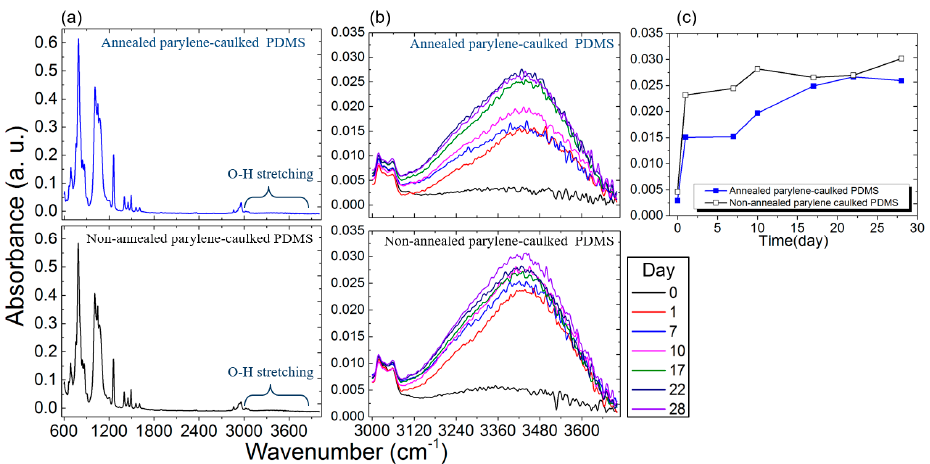
Figure 3. ( a ) Initial FTIR spectrum as soon as the electrodes were immersed in PBS solution; ( b ) FTIR spectrum from 3000 cm − 1 to 3700 cm − 1 to show the water amount absorbed in substrates of annealed pc-PDMS and non-annealed pc-PDMS for comparison; and ( c ) temporal changes in IR spectrum at 3450 cm − 1 to show the water amount absorbed in substrates of annealed and non-annealed